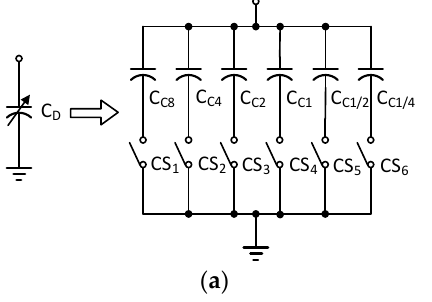
Figure 4. ( a ) The structure of 𝐶 (cid:3005) ; ( b ) switches’ control circuit.